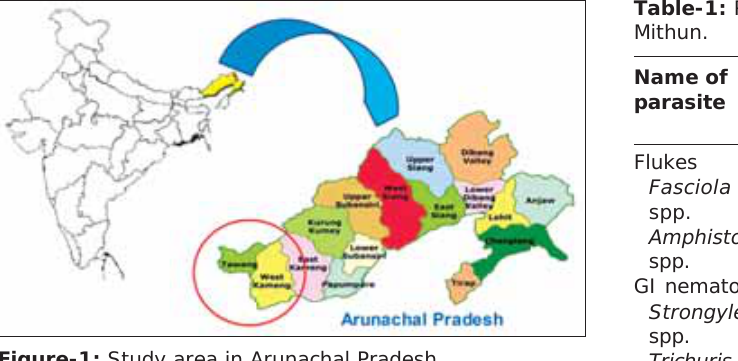
Figure-1: Study area in Arunachal Pradesh.